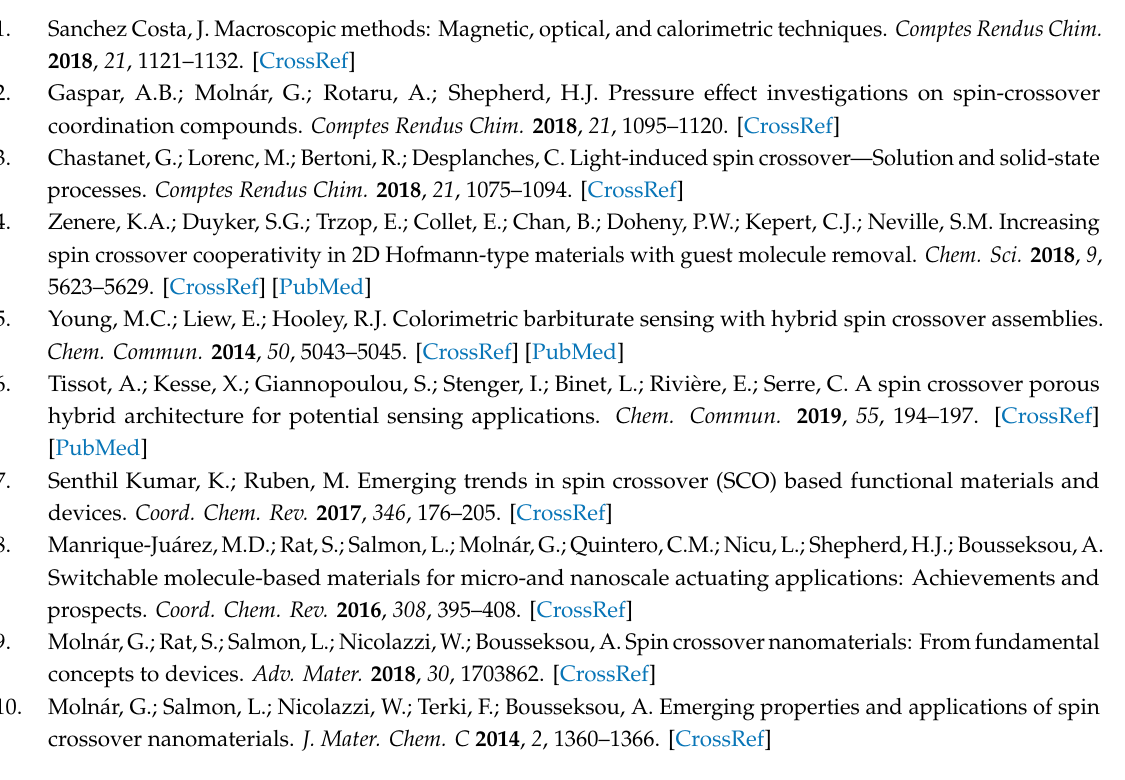
Figure S1: Plots of χ M T vs T for compound 1-Sol three cycles. Figure S2: Plots of χ M T vs T for compound 1-Mech three cycles Figure S3: Plots of χ M T vs T for compound 1-BM10 three cycles Figure S4: Plots of χ M T vs T for compound 1-BM90 three cycles. Table S1: Coordination spheres, interionic distances (R), variance of the absorber-scatterer distances ( σ 2 ), energy shift (E f ) and quality of fit (R-fit) of the EXAFS data for ( 1-Sol , 1-Mech , 1-BM10 and 1-BM90 ). Figure S5: TGA plot of % mass vs temperature for 1-Sol . Collected between 50–500 ◦ C with a heating rate of 10 K / min. Figure S6: TGA plot of % mass vs temperature for 1-BM10 . Collected between 50–500 ◦ C with a heating rate of 10 K / min. Figure S7: TGA plot of % mass vs temperature for 1-BM90 . Collected between 50–500 ◦ C with a heating rate of 10 K / min. Figure S8: TGA plot of % mass vs temperature for 1-Mech . Collected between 50–500 ◦ C with a heating rate of 10 K / min. Figure S9: Additional TEM images for 1-Sol . Figure S10: Additional TEM images for 1-Mech . Figure S11: Additional TEM images for 1-BM10 . Figure S12: Additional TEM images for 1-BM90 . Figure S13: TGA plot of % mass vs temperature for 1-Sol-10 . Collected between 50–500 ◦ C with a heating rate of 10 K / min. Figure S14: TGA plot of % mass vs temperature for 1-Sol-30 . Collected between 50–500 ◦ C with a heating rate of 10 K /